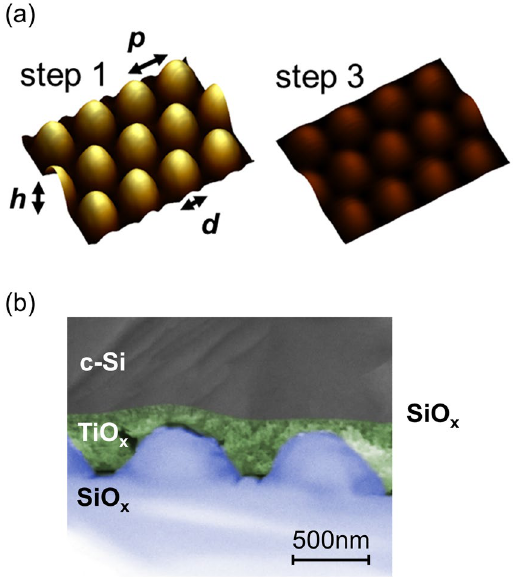
Figure 2. ( a ) Exemplary atomic force microscope images showing the hexagonal SiO x nano-pillar array (cf. step 1 in Fig. 1) and the surface of the SMART texture (cf. step 3 in Fig. 1) with the same height scaling. The characteristic texture parameters are outlined. ( b ) Exemplary scanning electron microscope image of a SMART texture with a silicon absorber on top. For clarification, the SiO x (blue) and TiO x (green) layers have been colored. The thin SiO x passivation layer is not